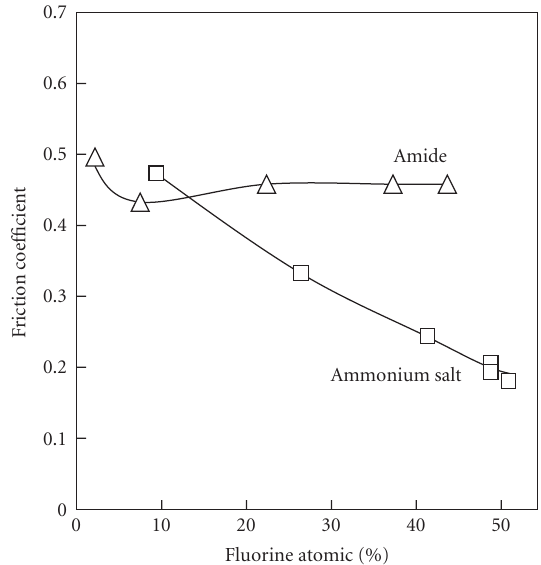
Figure 8: Relation between the relative intensity of fluorine atom on the tape surface and friction coe ffi cient after 100 cycles of reciprocating